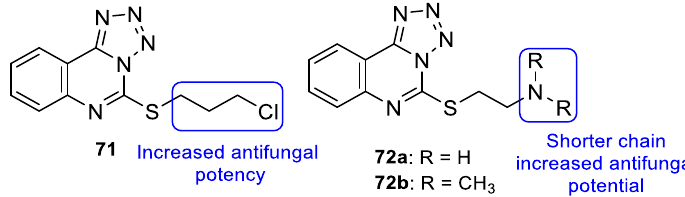
Figure 37. Chemical structures of compounds 71 and 72a – b, and SAR [117]. The series of tetrazole-pyrimidine synthesized by Vembu et al., tested using the broth microdilution method against C. albicans , S. cerevisiae , A. niger , and A. fumigatus , showed great potency against the tested fungi (MIC < 0.4 to 15 µ M, apart from one value) compared to MIC values of fluconazole (MIC ranging from 0.52 to 8.2 µ M—not concordant with literature results for A. fumigatus ). Compounds 73 , 74 , and 75 (Figure 38) demonstrated high antifungal activity against all strains (with MIC values ranging from <0.4 to 15 µ M), with 75 being the most effective one and, in some cases, stronger than fluconazole. Additionally, erally more active than the unsubstituted ones [118].